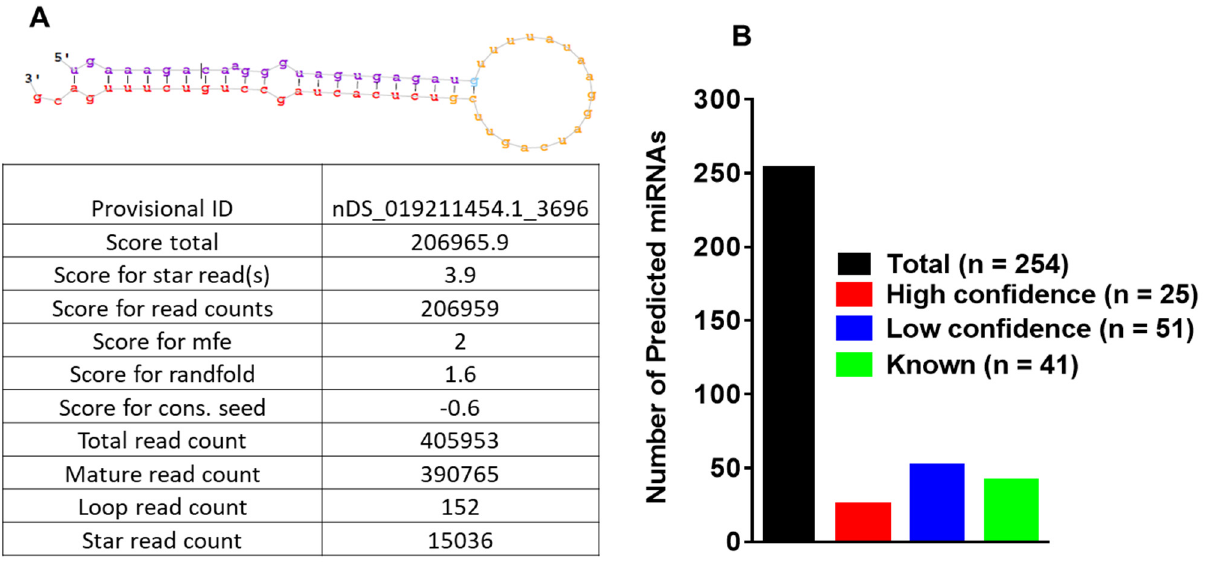
Figure 2. ( A ) Basic stem-loop structures of predicted microRNAs. miRDeep2 was used to identify potential miRNA precursors based on nucleotide length, star sequence, stem-loop folding, and homology to the Ixodes scapularis reference genome. Shown are the predicted stem-loop structures (yellow), star (pink), and mature sequences of predicted miRNAs (red) in the salivary glands of Ixodes scapularis ticks. ( B ) Annotation of predicted miRNAs in partially fed uninfected (clean) and Borrelia-burgdorferi -infected Ixodes scapularis salivary glands. Further, 254 microRNAs were predicted in infected and uninfected salivary gland tissues, 25 were categorized as high confidence ( n = 25) and 51 as low confidence ( n = 51) based on standard criteria and a conservative approach. Out of 49 Ixodes scapularis miRNAs available in miRbase (v22.1), 41 were detected in this study.